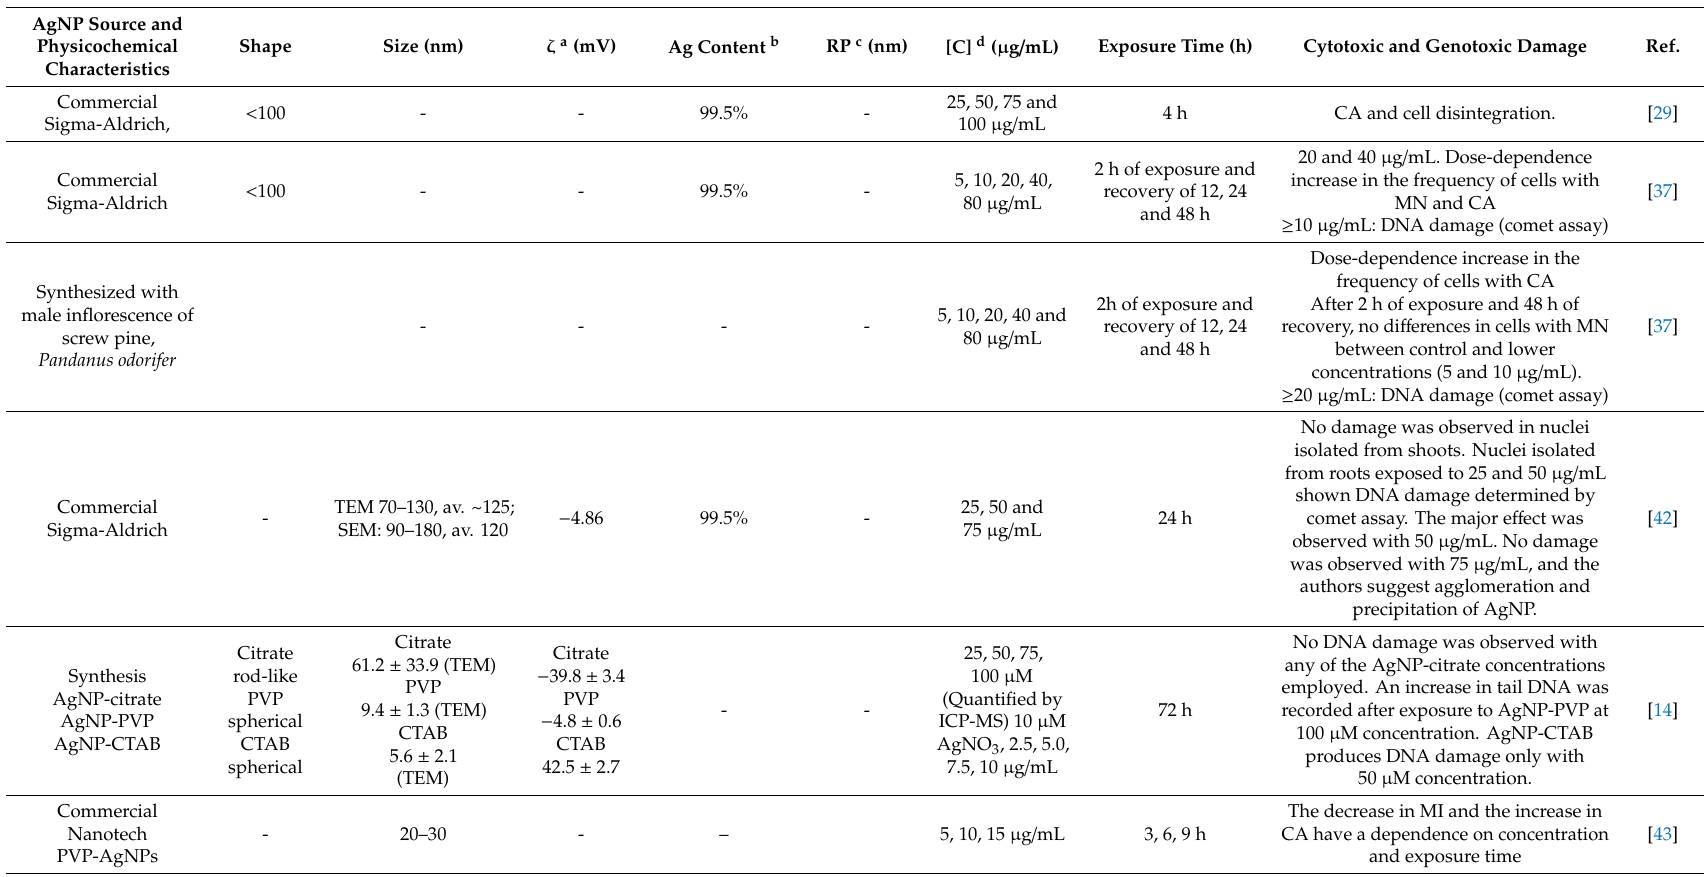
Table 1. Comparative analysis of cyto-genotoxicity of Argovit ™ AgNPs with other AgNPs formulations described in the